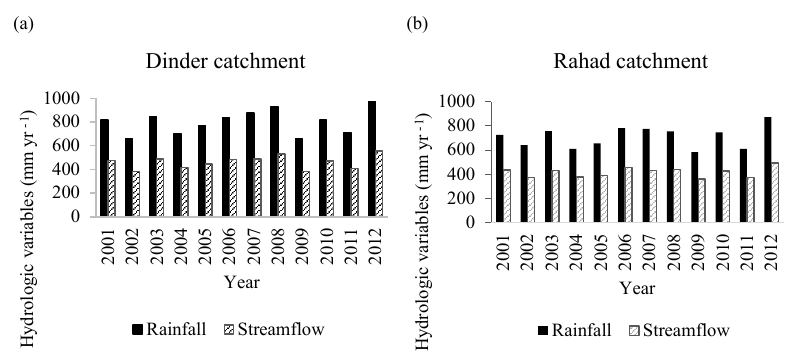
Figure 10. Annual average rainfall and streamflow patterns and magnitudes for the years 2001–2012, (a) for the Dinder catchment and (b) for Rahad catchment. Table 5. Annual average AET as a response to LULCC at the sub-catchment level for the Dinder catchment (1972–1986). AET from land cover data from 1972 (mm) AET from land cover data from 1986 (mm) Year Al Gewisi Musa Gelagu Upper Dinder Al Gewisi